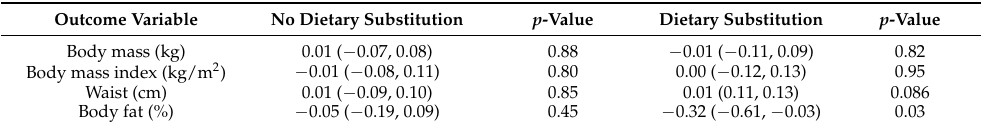
Table 1. Stratified overall mean change in anthropometric measures for nuts with and without dietary substitution guidance